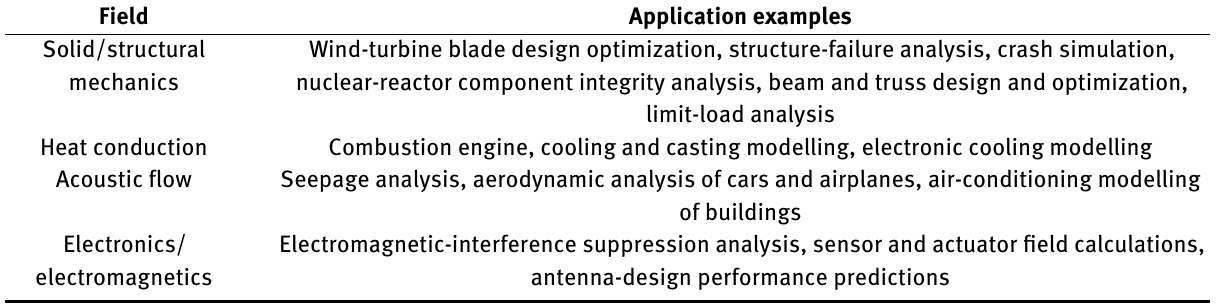
Table 1: Finite-element method (FEM) applications [22]